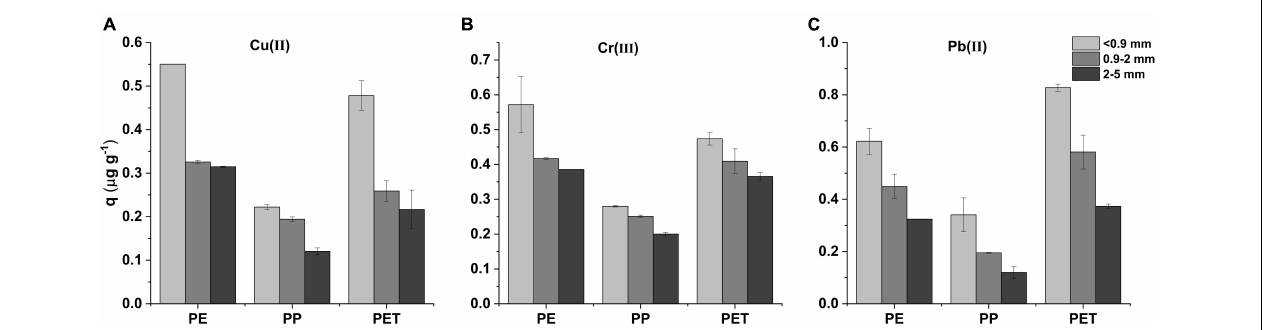
FIGURE 4 | (A) The Cu(II), (B) Cr(III), and (C) Pb(II) adsorption capacities of PP, PE, and PET microplastics with different particle sizes in 240